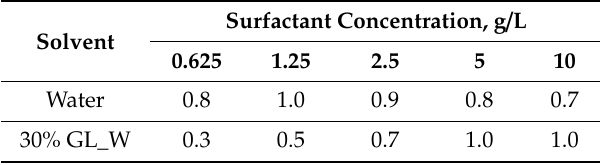
Figure 9. Spreading kinetics of BT-240 solutions in water ( a ) and in 30% glycerol / water mixture ( b ) on the PVDF substrate. Surfactant concentrations are given in the graph legend. Table 2. Maximum spreading exponent for solutions of BT-240 on